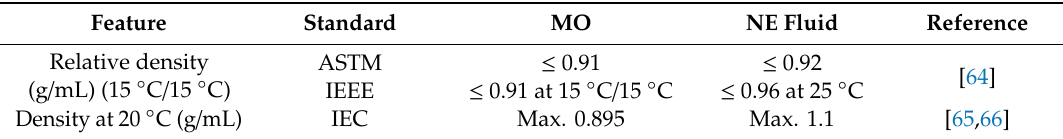
Table 7. Relative density of various insulating